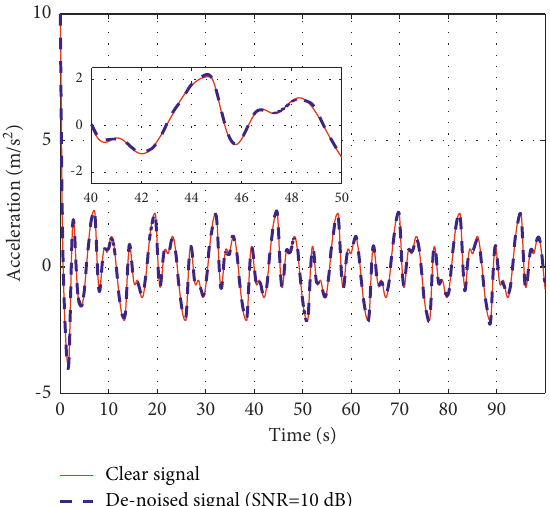
Figure 11: Noise elimination of non-linear signal using proposed method when SNR � 10 dB.